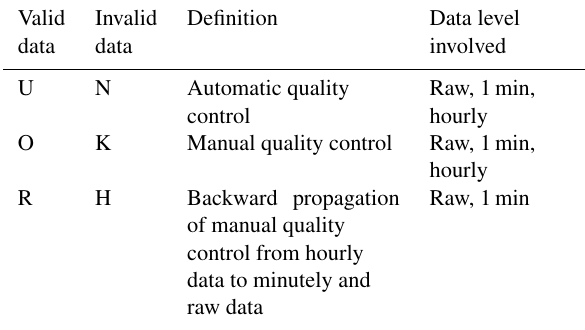
Table 1. List of user flags. The user flag is instrument independent. Beyond the validity status of the data, each set of flags conveys addi- tional meaning. Automatic quality control flags imply that no expert has manually inspected the data yet, whereas manual quality con- trol flags imply that an expert has manually inspected the data. The backward propagation of manual quality control flags implies that an expert has performed manual inspection of the corresponding aggregate data but not the data directly.